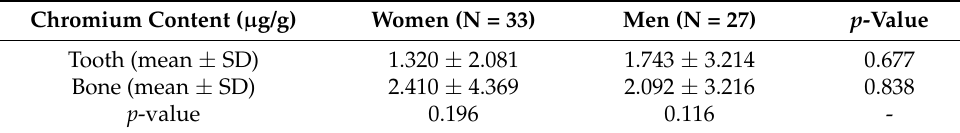
Table 16. Chromium content in tested samples taken from patients of different sexes.